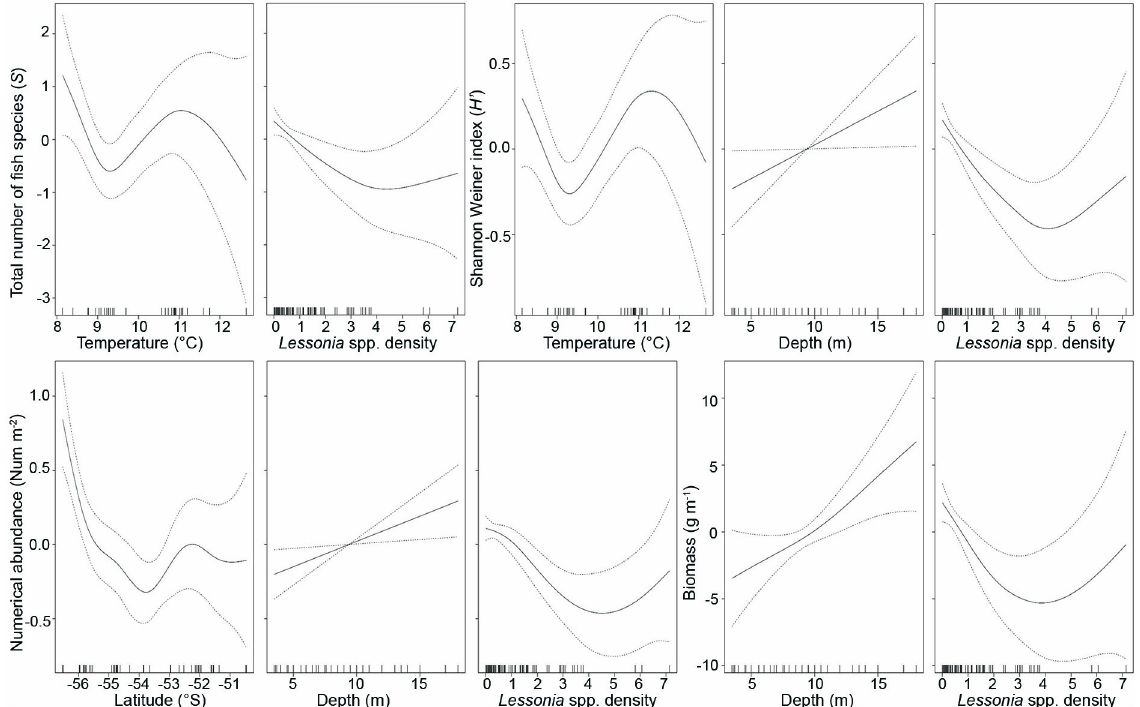
Fig 6. Smoothed estimates (solid line) for the environmental predictors temperature, Lessonia spp. density, depth and latitude as obtained by the best-fitting Generalized Additive Models (GAMs) for the total number of fish species ( S ), Shannon-Weiner index ( H ’), numerical abundance and biomass. Dashed lines are 95% confidence intervals. Tick marks on the x-axis are sampled data points.